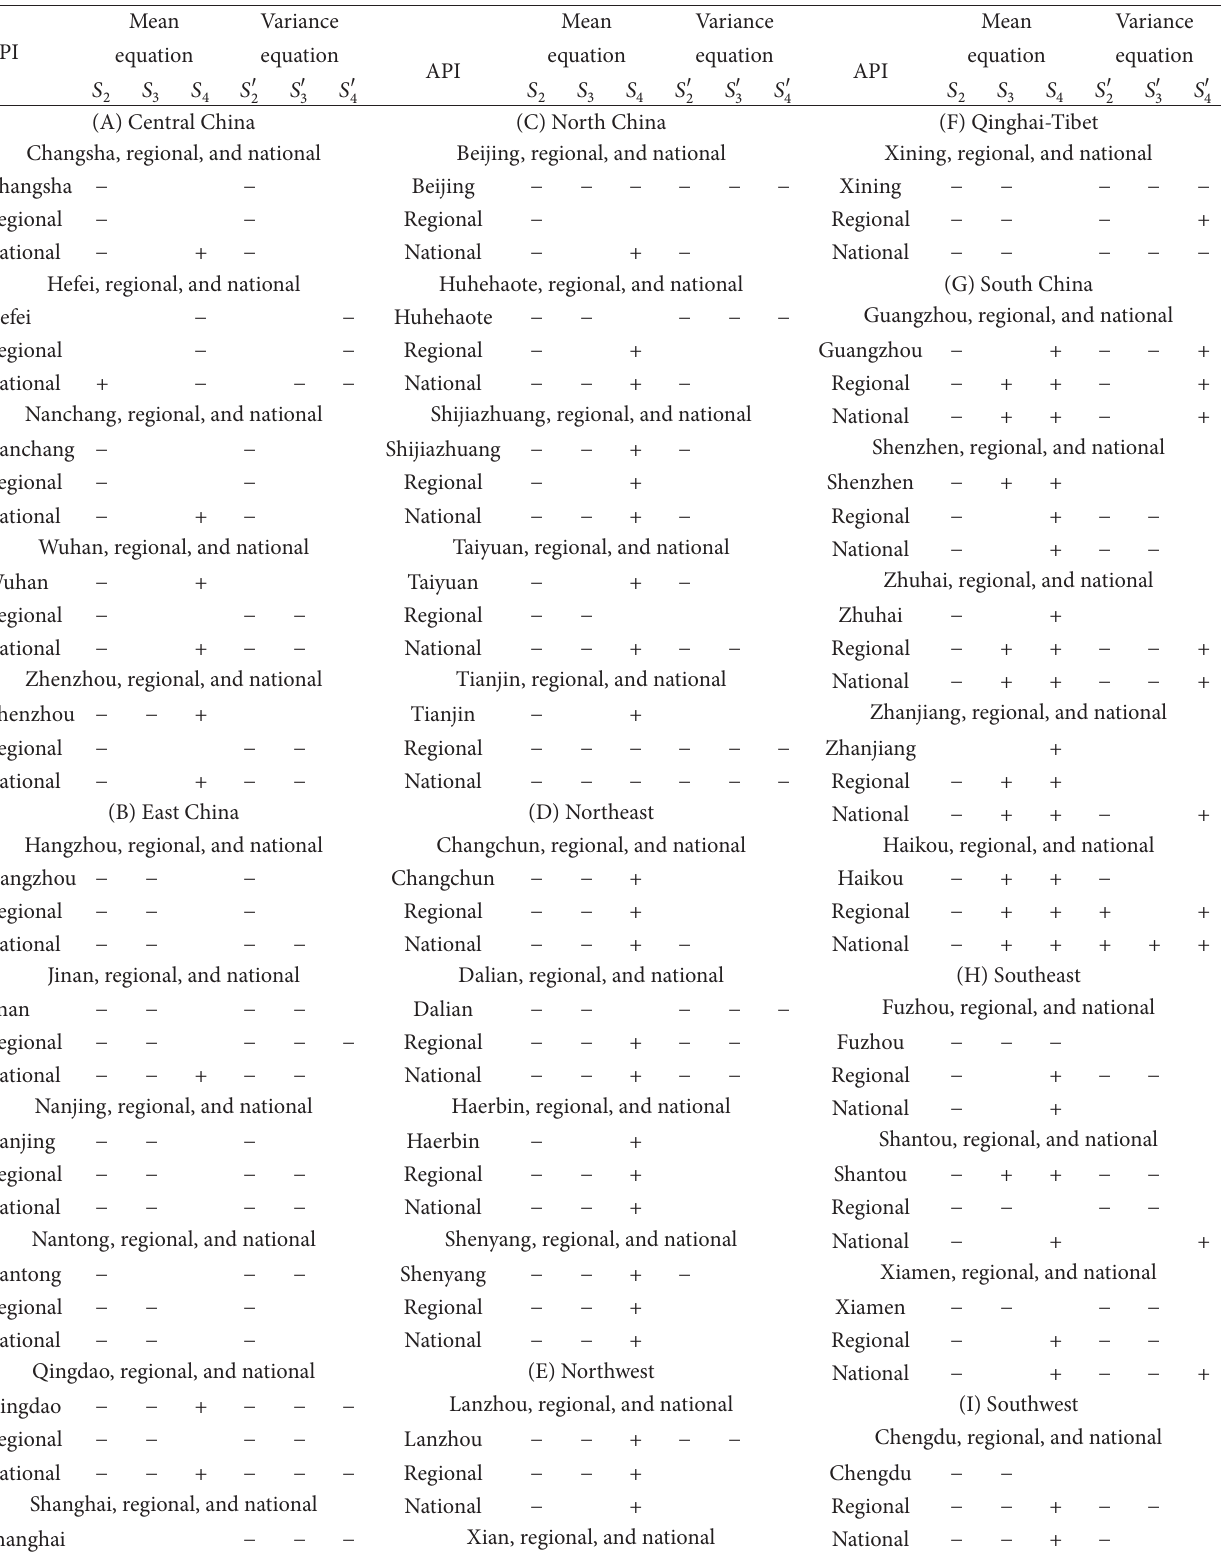
Table 4: Seasonality